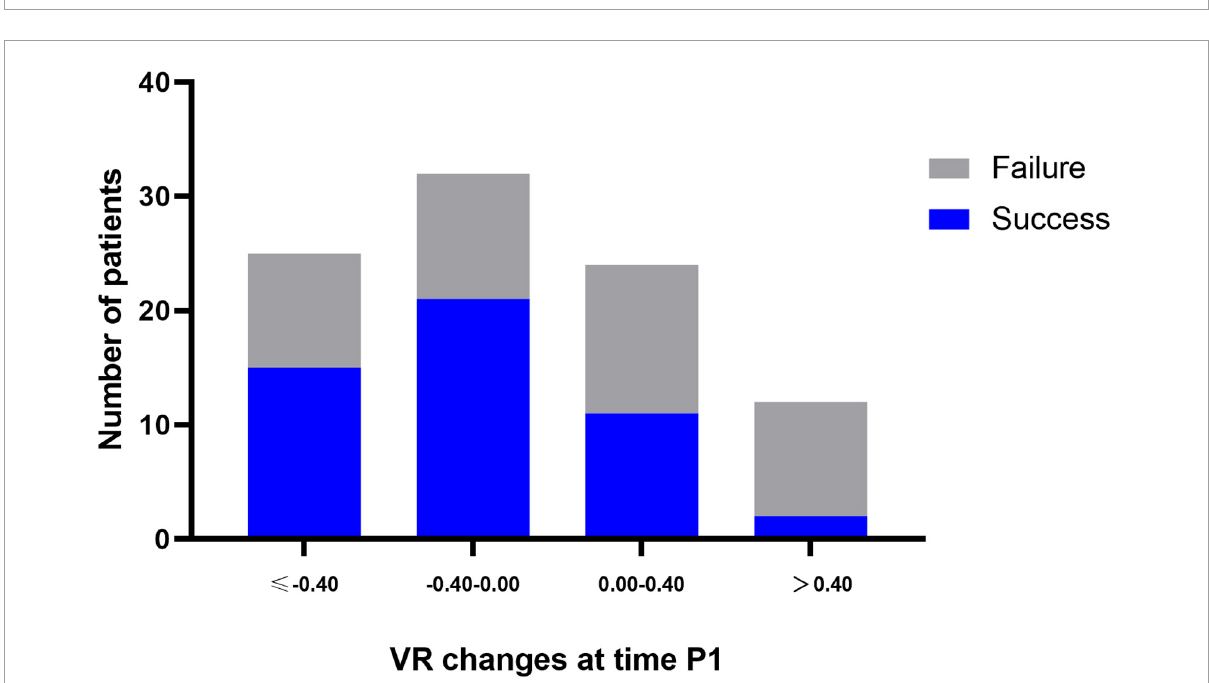
FIGURE3 Proportion of patients with successful weaning according to the change of VR within 4 h after prone positioning (time P1). Blue plots represent successful weaning patients at day 28, whereas, gray plots represent weaning failure patients at day 28. –0.40 was 33rd percentile of VR change at time P1.